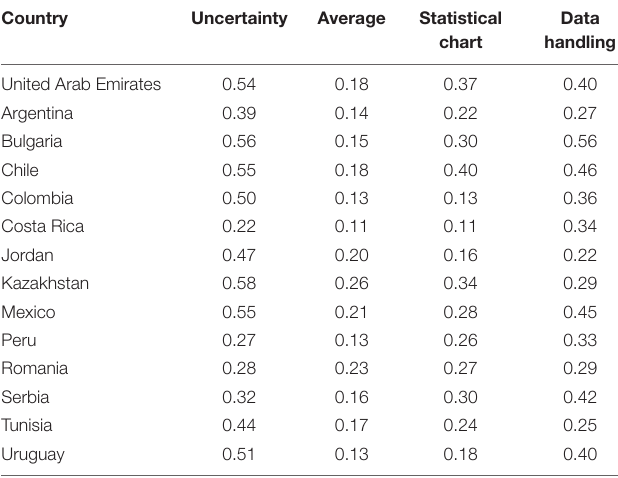
TABLE 5 | Average value of the EAP in 14 countries.